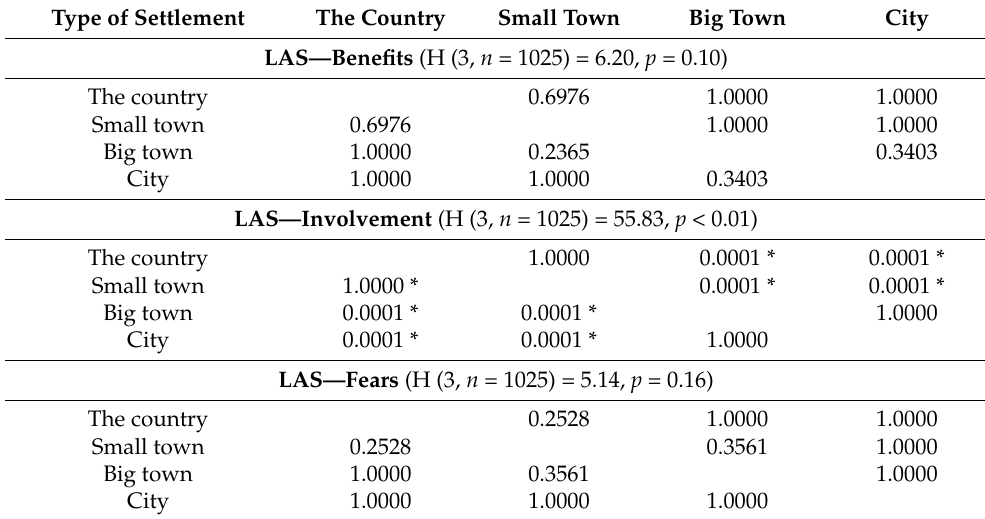
Table 5. Significance of differences between groups in reference to type of place of residence—results of post-hoc analysis.